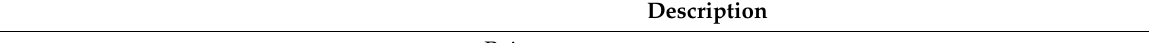
Table 1. Descriptions of the points and the measurements used in this